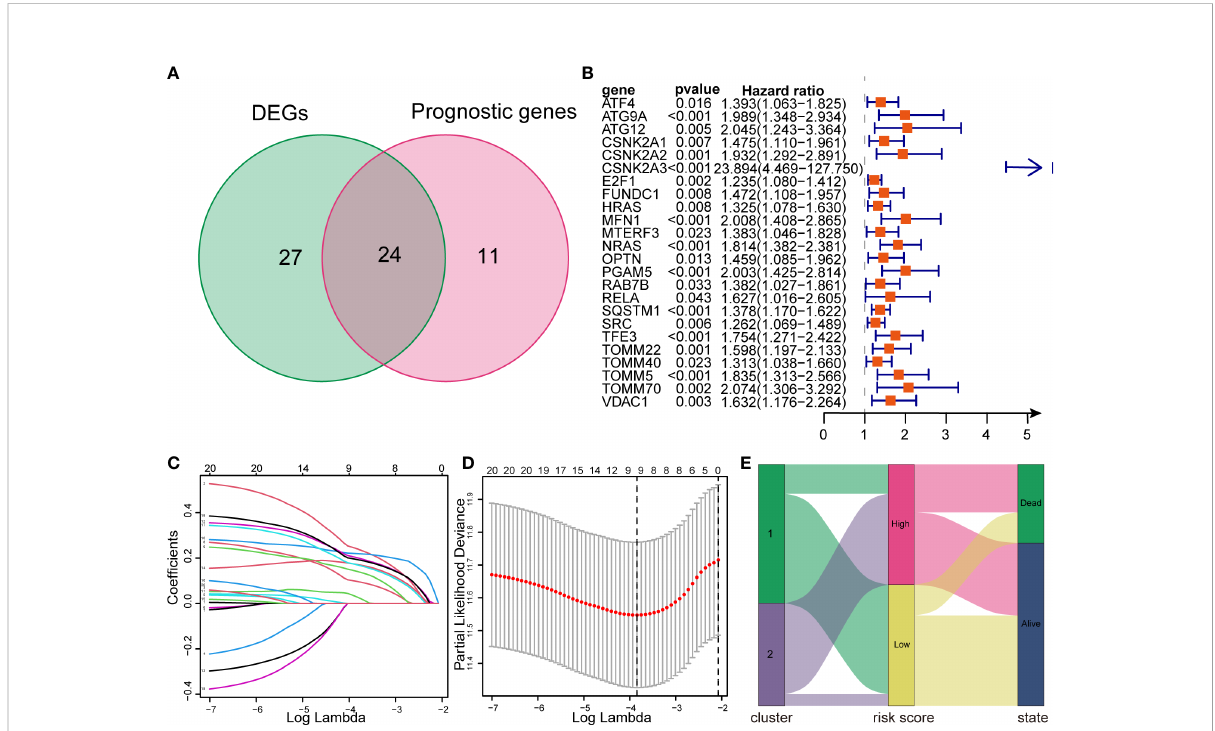
FIGURE 7 Construction of a LASSO regression model and correlation between subtypes and risk groups. (A) Venn diagram showing intersection between DEMs and prognostic genes. (B) Forest plots showing the results of univariate Cox regression analysis of overlapped genes. (C, D) LASSO regression analysis of the overlapped genes. (E) The Sankey diagram showing the distribution of patients in mitophagy-related subtypes, risk groups and survival outcomes. LASSO, Least absolute shrinkage and selection